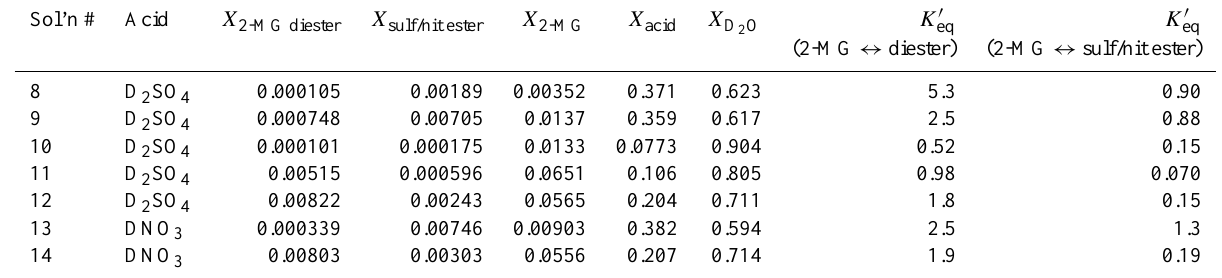
Table 8. Equilibrium mole fraction composition for sulfuric and nitric acid controlled composition experiments. Sum of listed mole fractions not equal to unity due to presence of NaClO 4 and trace